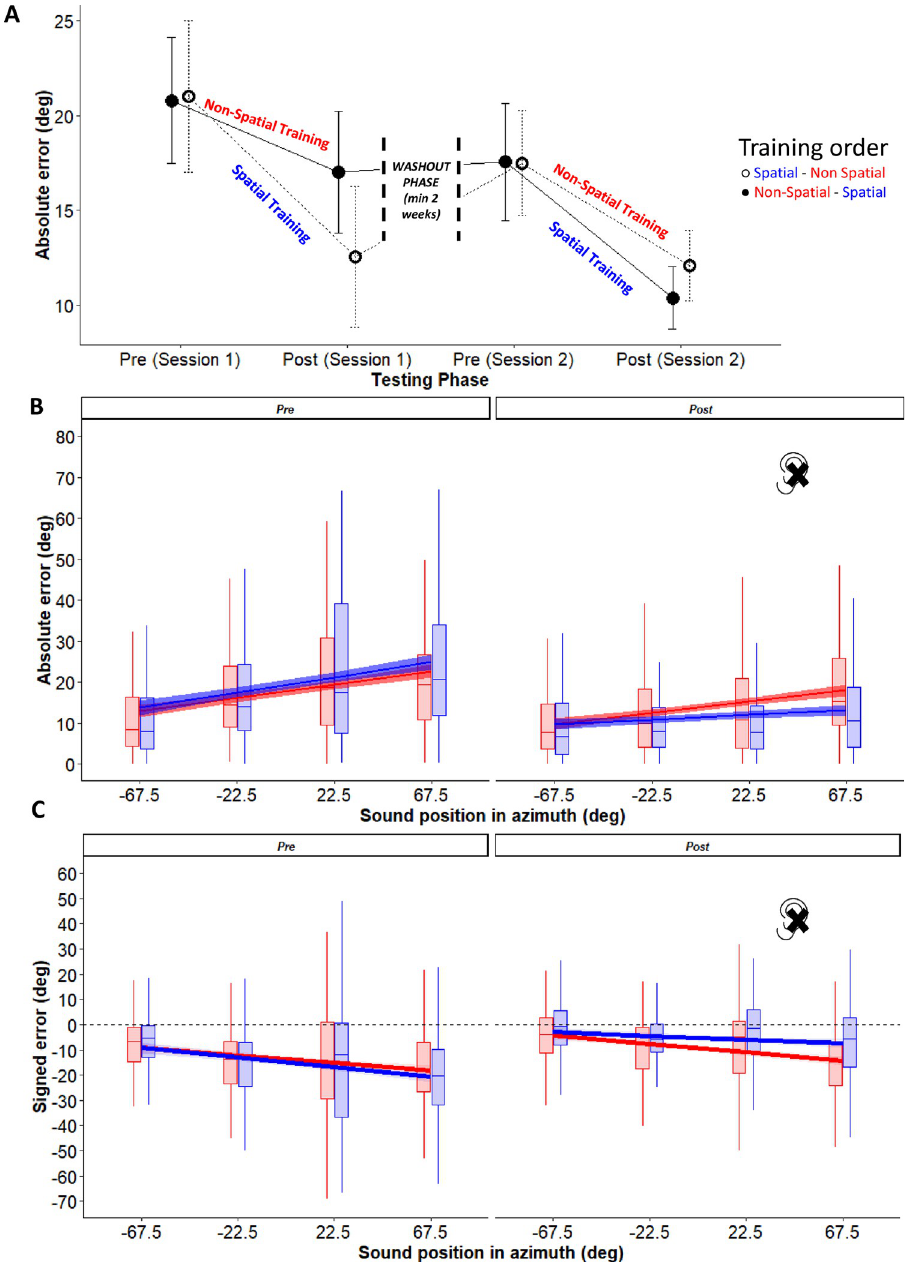
Fig 4. Performance in head-pointing sound localization. Top: (A) Progression of absolute localization across the four testing sessions of the experimental design, separately for participants who completed the Spatial training on session 1 (open circles and dashed line) or session 2 (filled circles and continuous line). Bottom: Absolute (B) and signed (C) errors (in degrees) in monaural listening are plotted as a function of sound position in azimuth, separately for each training type (blue: Spatial training; red: Non-spatial training). For the signed error negative values indicate a bias toward the unplugged side. Dashed lines indicate the 95% confidence intervals of the overall linear regression. Sound positions have been grouped as a function of azimuth and irrespective of